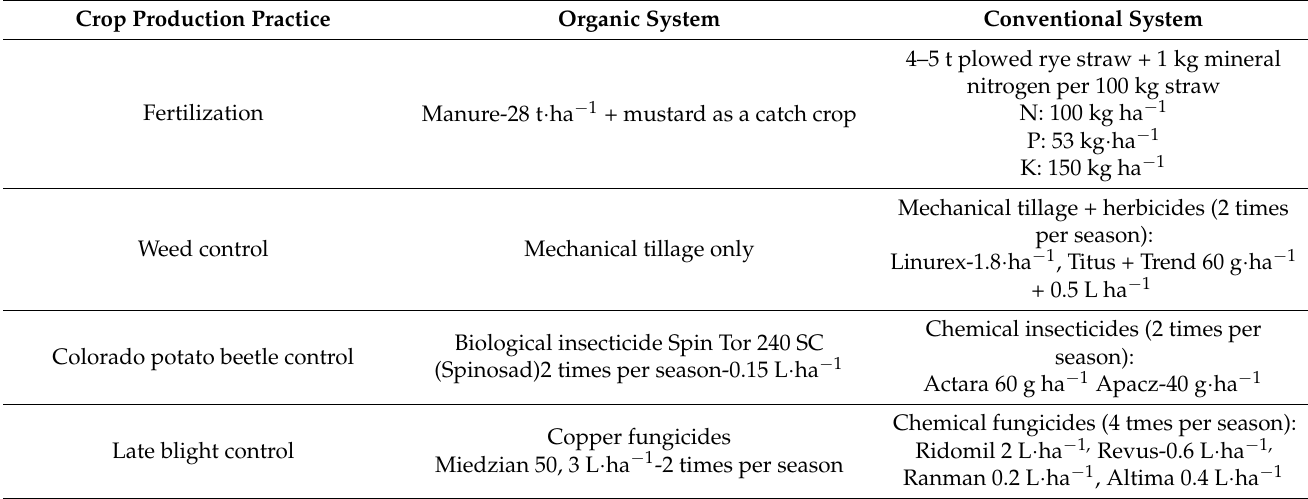
Table 1. Agronomic inputs in the organic and conventional systems, Jadwisin, 2018–2020.